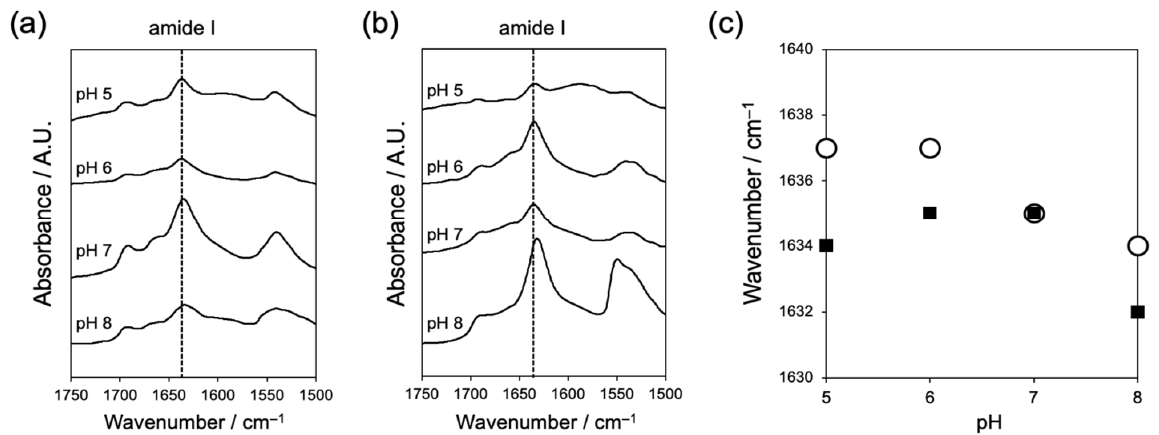
Figure 3. ( a , b ) Fourier transform-infrared spectroscopy (FT-IR) spectra of Fmoc-L 2 QG ( a ) and Fmoc-L 3 QG ( b ) at pH 5–8 and ( c ) amide I peak positions of Fmoc-L 2 QG (open circle) and Fmoc-L 3 QG (closed square) at pH 5–8.